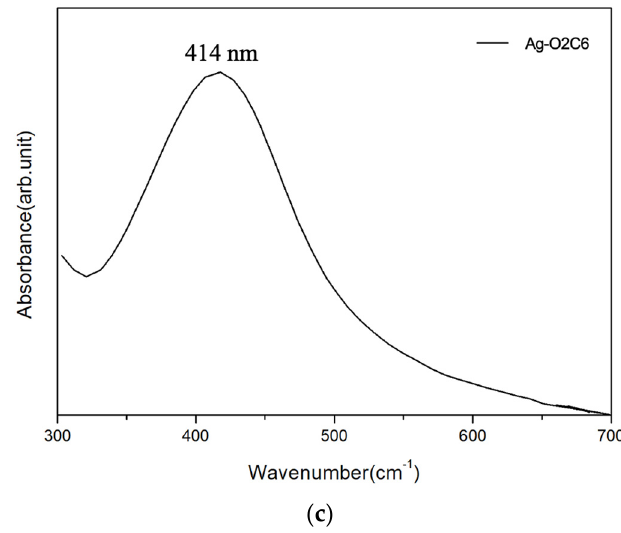
Figure 3. ( a ) TEM image and ( b ) diffraction patterns of Ag NPs, as well as ( c ) UV-vis spectrum.